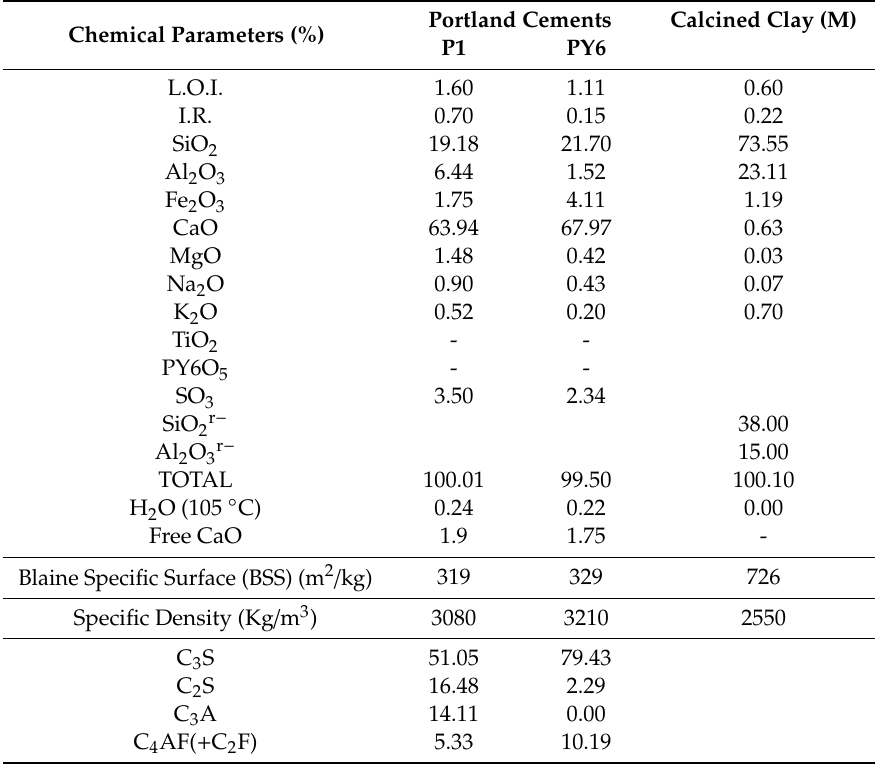
Table 1. Physics-Chemicals determinations of